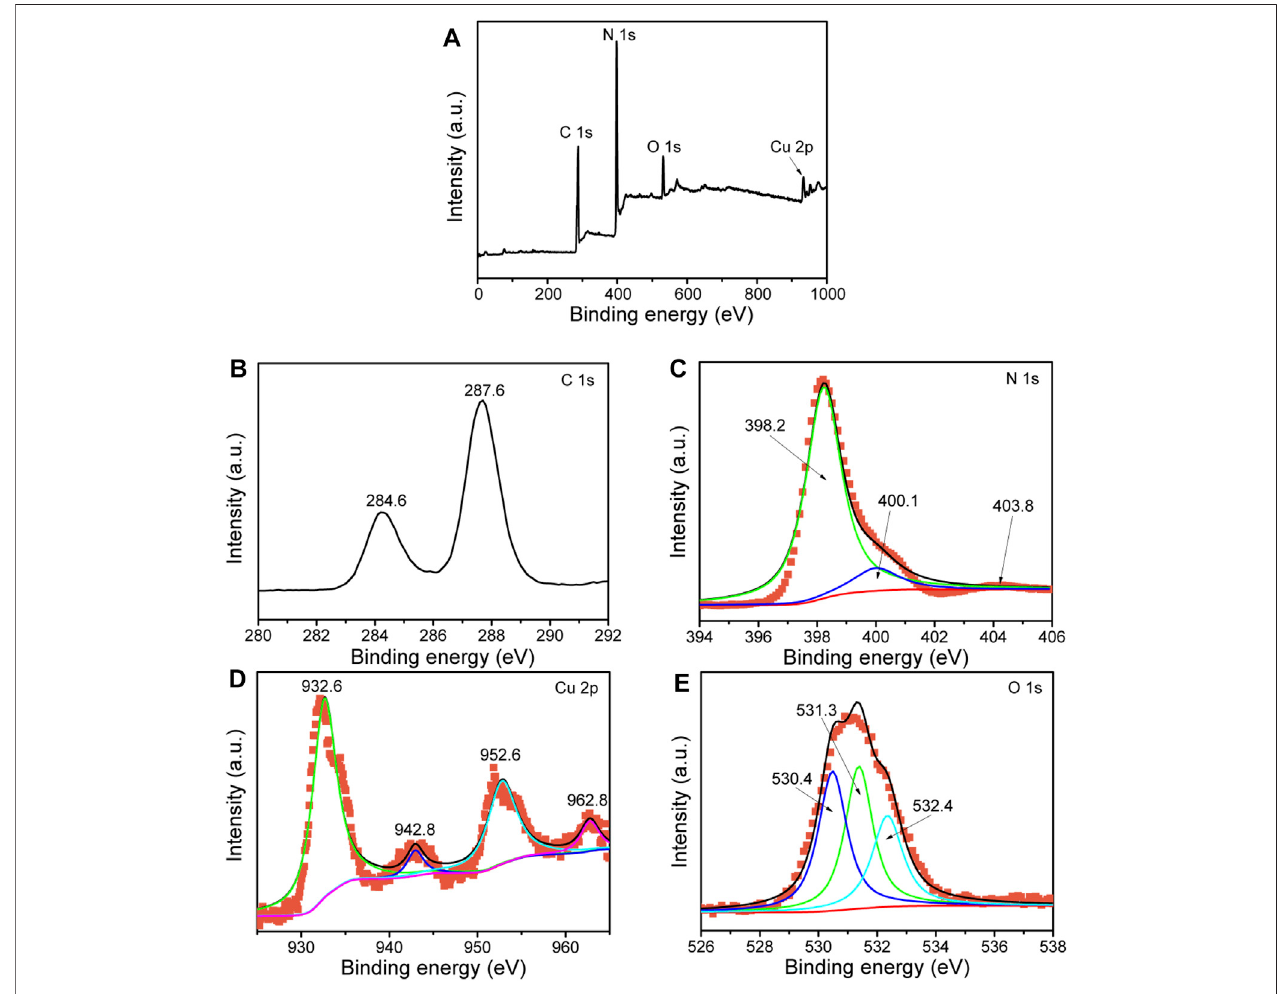
FIGURE 6 | X-ray photoelectron spectroscopy (XPS) spectra of 7%-CuO/g-C 3 N 4 : survey scan (A) , C1s (B) , N1s (C) , Cu2p (D), and O1s (E) .